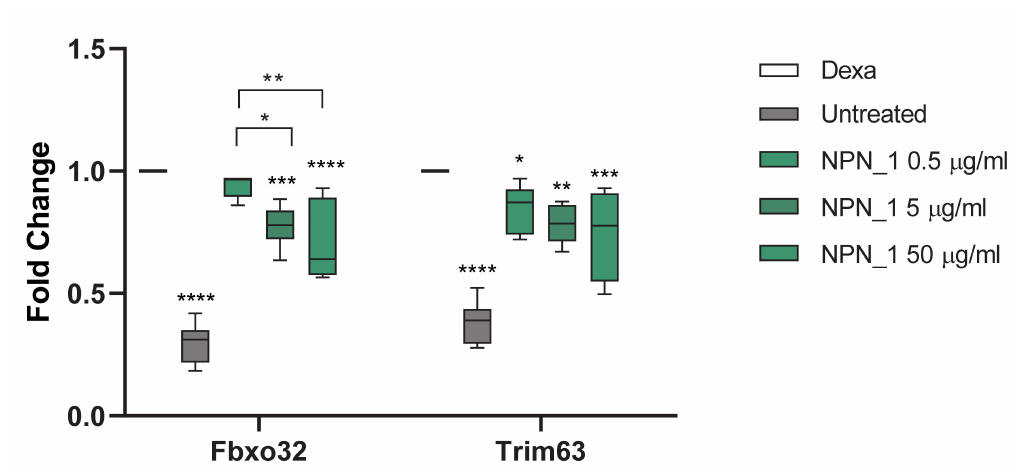
Figure 3. E ff ect of NPN_1 on atrophy related gene expression. The PCR analysis was carried out on atrophy induced C2C12 cells showing the e ff ect of NPN_1 on Fbxo32 and Trim63 gene expression. Cells were treated with dexamethasone (Dexa; 0.3 µ g / mL) for 24 h, 30 min prior to the end of the dexamethasone treatment, NPN_1 (0.5–50 µ g / mL) was added. Untreated cells were not treated with dexamethasone or NPN_1 (two-way ANOVA with Tukey’s multiple comparisons test; * p < 0.05;